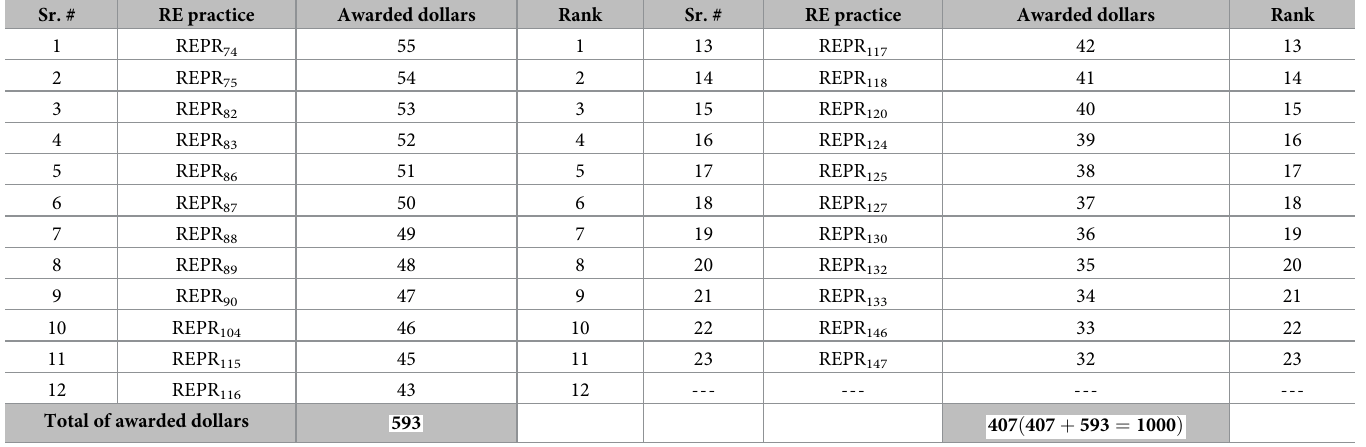
Table 7. RE Practices belonging to ‘Low’ importance group along with respective ranks within group. Sr. #